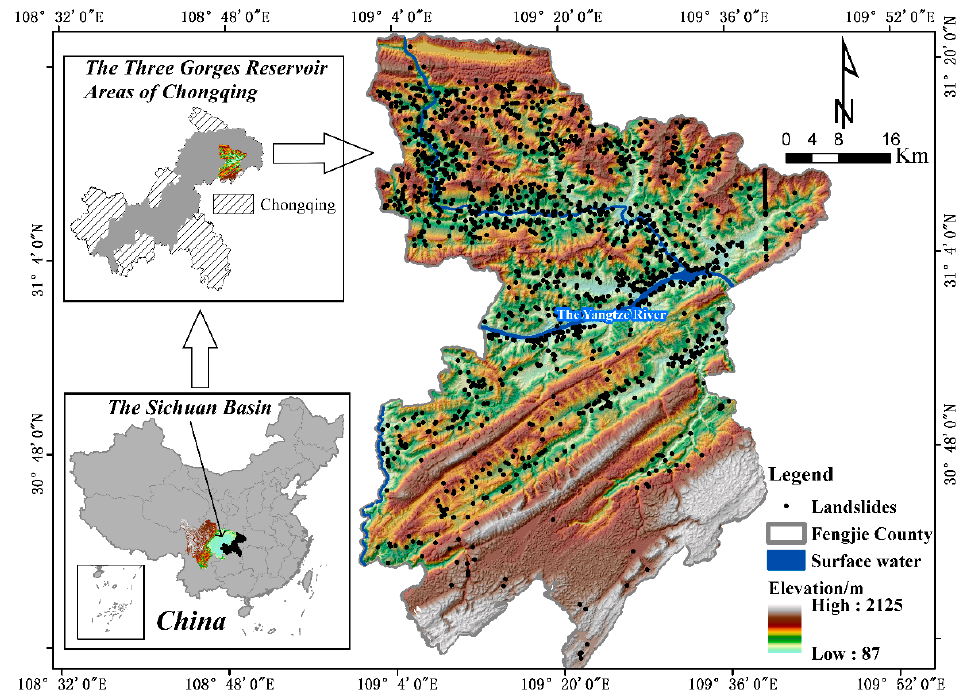
Figure 1. Location and landslide distribution of Fengjie County.